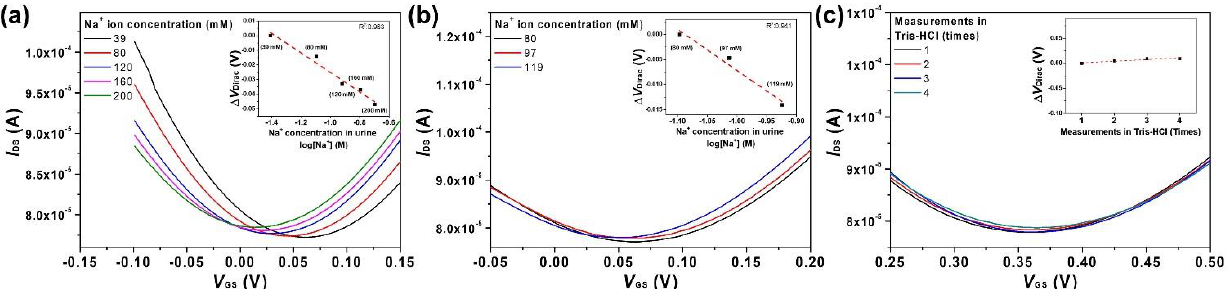
Figure 6. Detection of Na + ions in real human patient urine samples using G–ISFET–ISM with FG–RE. Linear fits were used to extract sensitivity: ( a ) I DS – V GS plots at different Na + concentrations in the same urine sample (added by titration); ( b ) I DS – V GS plots of three different urine samples; and ( c ) I DS – V GS of G–ISFET–ISM with FG–RE in Tris–HCl buffer between measurements of three different patient urine samples.